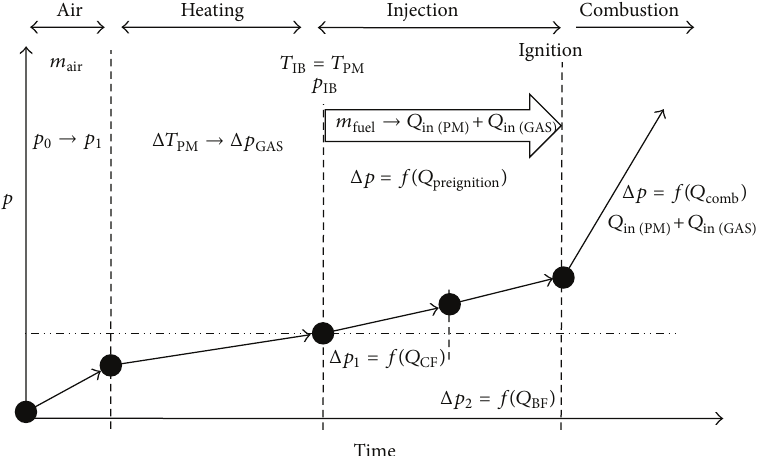
Figure 4: Routine of setting the test conditions (initial pressure and initial temperature) in free volume system and in porous